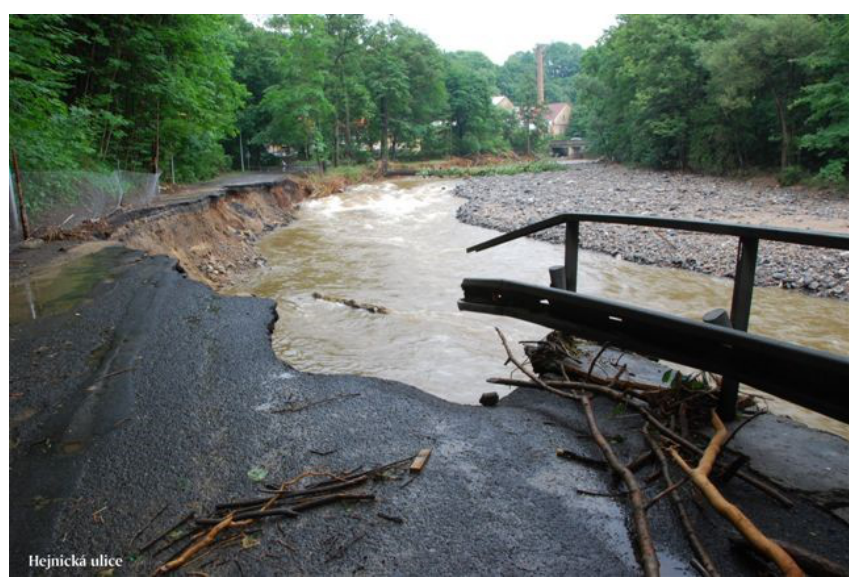
Figure 4. An example of lateral erosion of a transport embankment in the Frýdlant region, 2010.